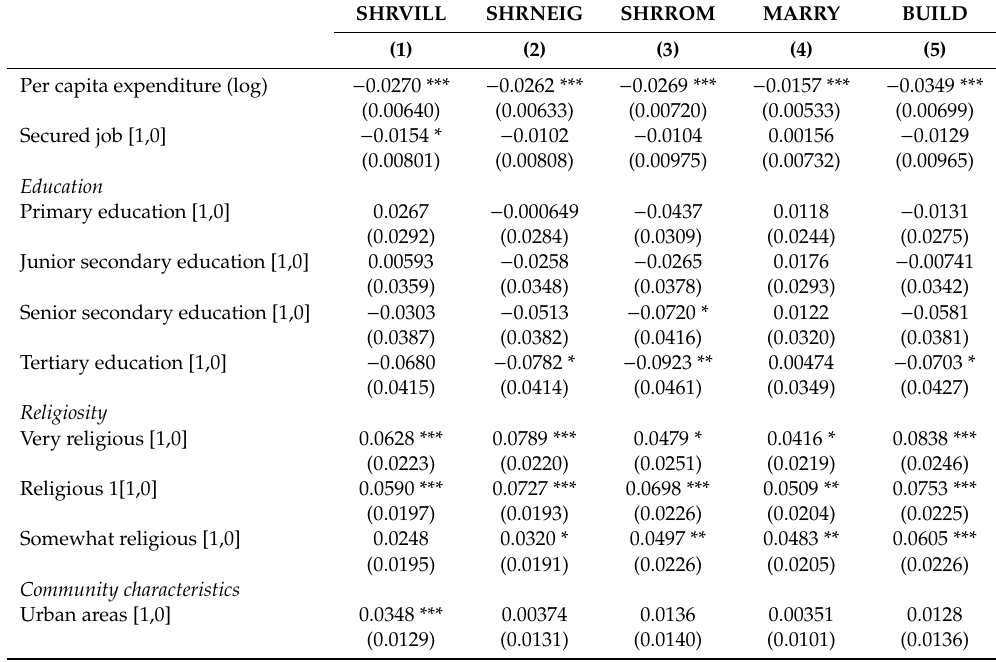
Table A1. Regression results (Fixed-e ff ect liner probability Model with Gini coe ffi